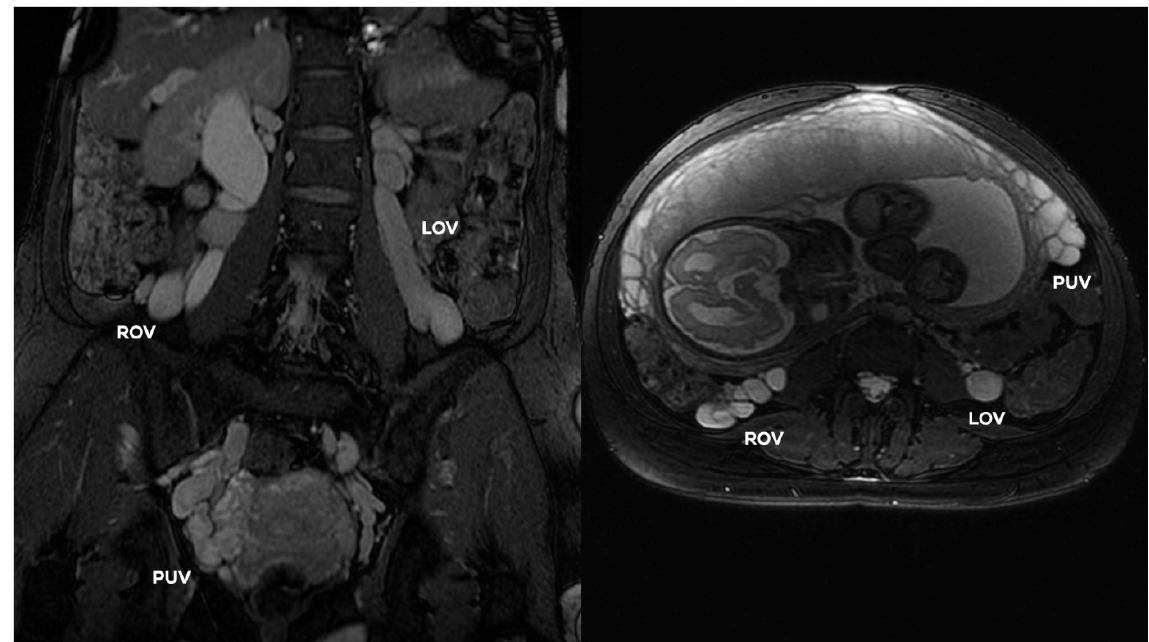
Figure 18. Prenatal MRI. Images in coronal and axial planes. Bilateral ovarian veins distention of 32-year-old woman in third pregnancy. (Courtesy of M. Bekiesinska-Figatowska, PhD; Department of Diagnostic Imaging, Institute of Mather and Child, Warsaw, Poland).